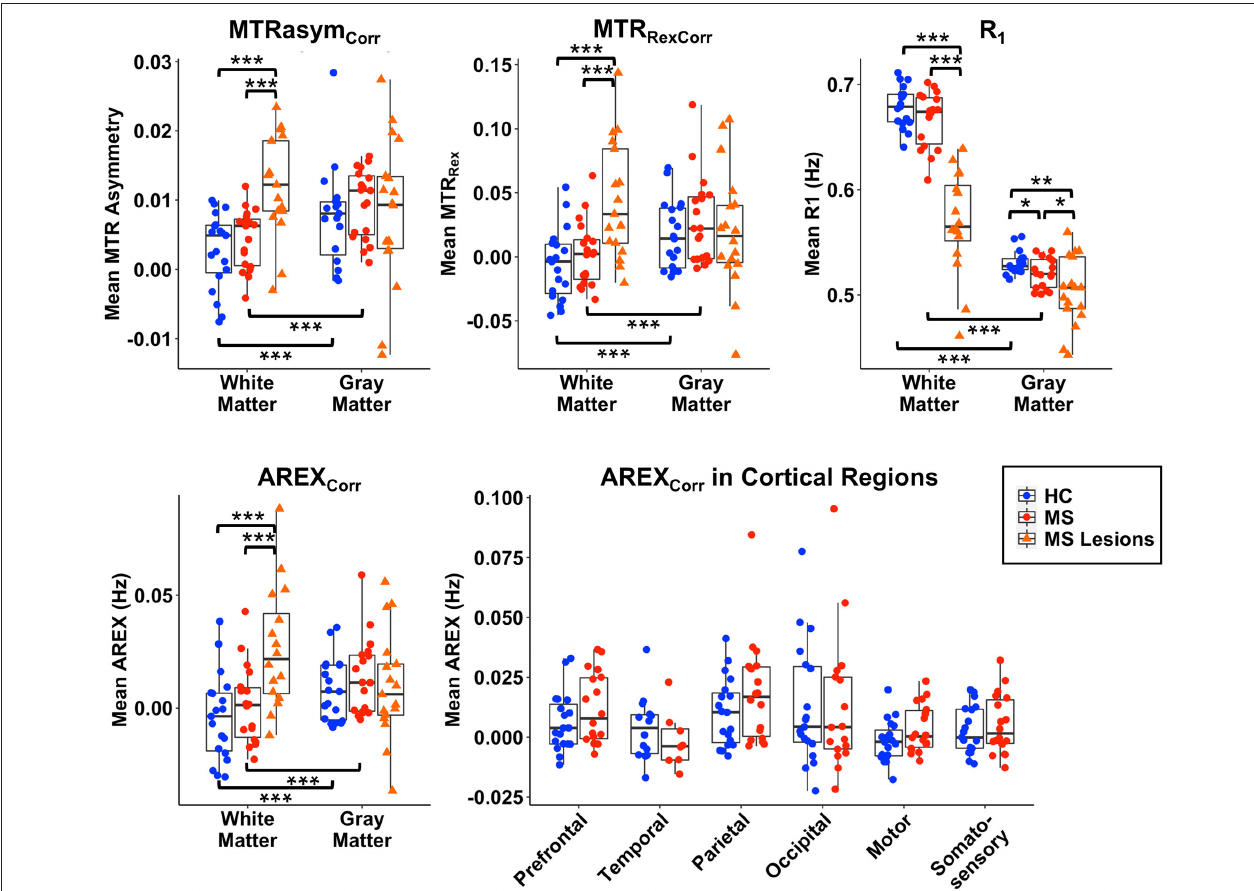
FIGURE 5 | Mean values of MTRasym Corr , MTR RexCorr , AREX Corr , and R 1 are shown for WM, GM, WM lesions, and cortical lesions for group comparisons. AREX Corr values are also shown for each cortical GM region. WM lesion values differ significantly from normal-appearing WM in MS patients and from healthy control (HC) WM for all CEST-derived indices and for R 1 . Significant differences between groups in GM and cortical lesions are only present in R 1 . No group differences are significant for AREX Corr within cortical regions. All indices differ significantly between GM and WM within each group. * p < 0.05, ** p < 0.01, *** p < 0.001.